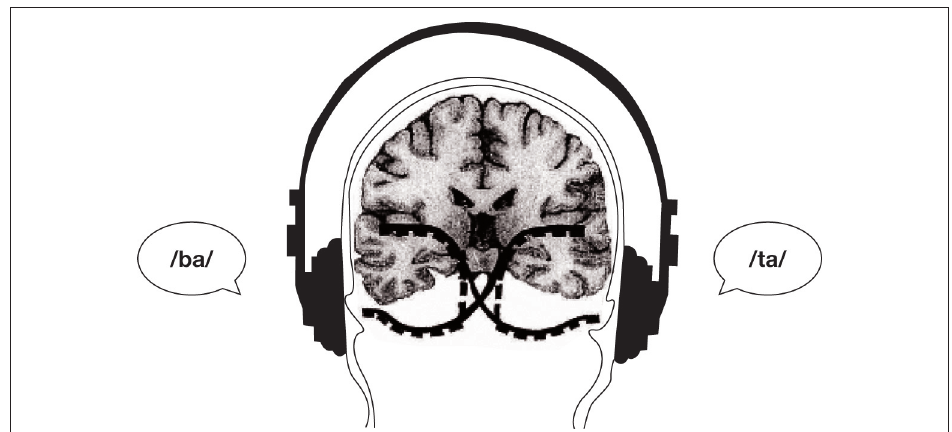
Figure 2 | Schematic illustration of the dichotic listening procedure in which two different consonant–vowel syllables are presented simultaneously, one syllable in the left ear and the other in the right ear. The task of the subject is to report the syllable heard/perceived on each trial. A trial with the syllable /ba/ presented in the left ear and the syllable /ta/ presented in the right ear is